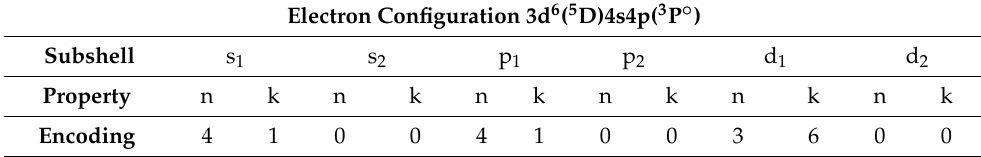
Table 1. Abbreviated example encoding for the excited electronic configuration of the LS-coupled 19,350.891 cm − 1 level of iron I. The subshell of the level is encoded through the column number in the array. The property n represents the principal quantum number and the property k represents the occupancy of the subshell in the nl k